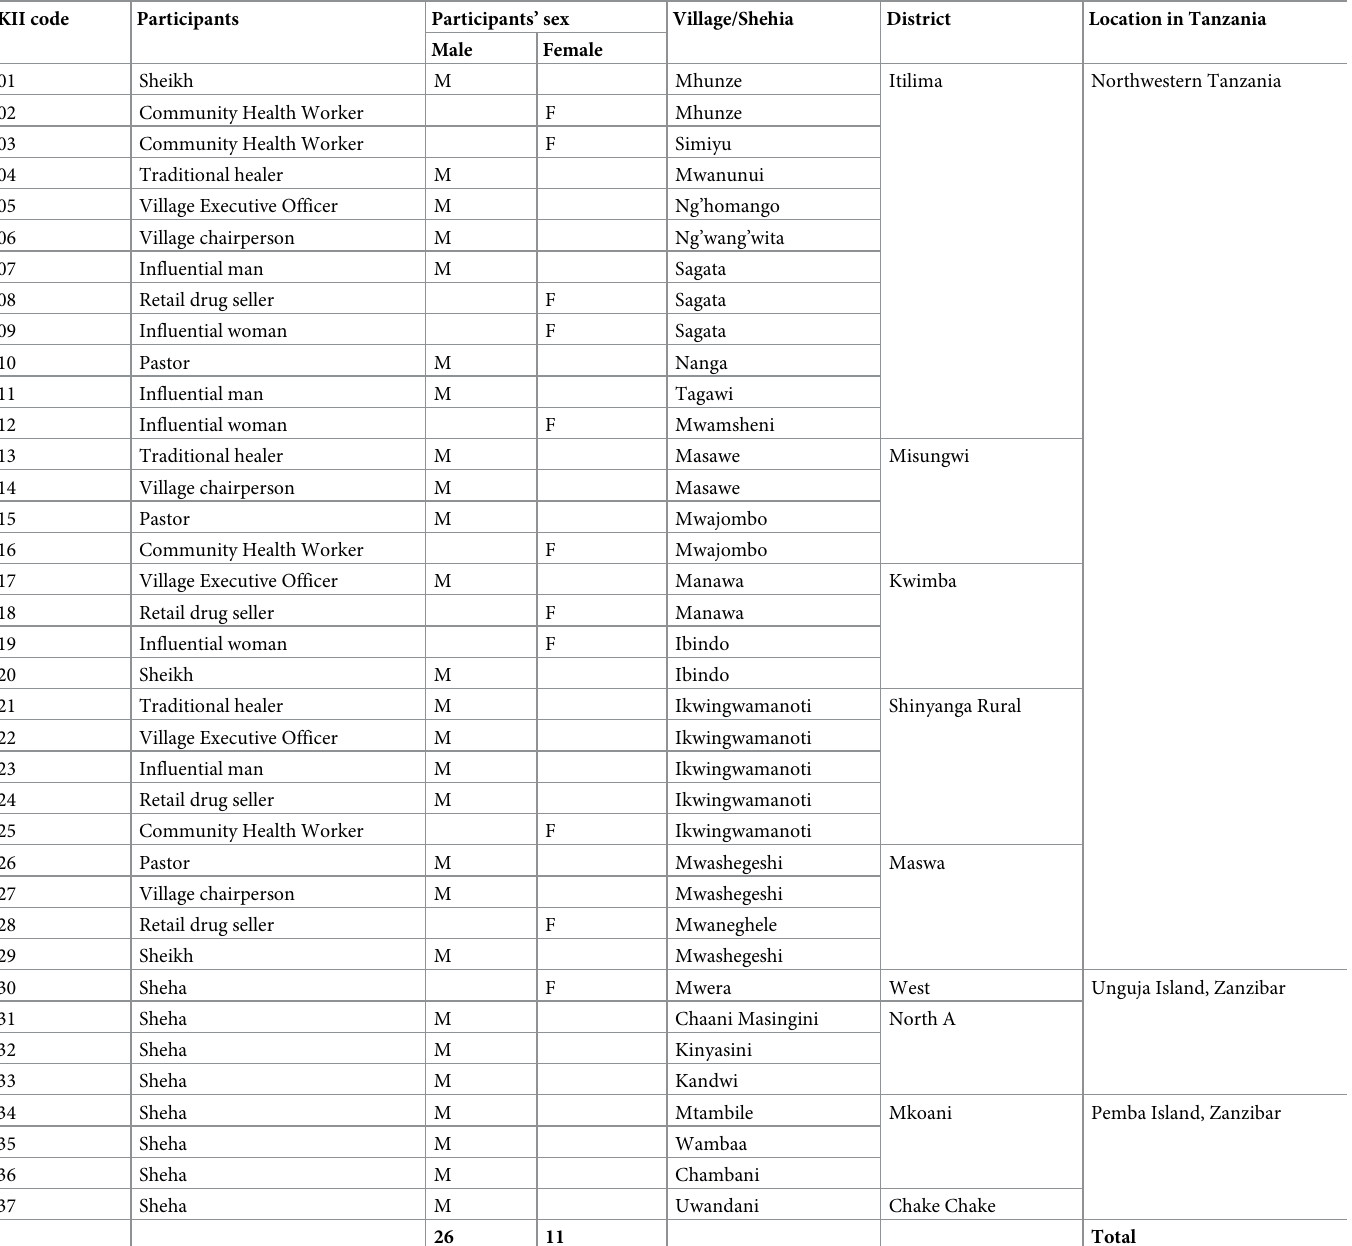
Table 2. Key informants, number of KIIs, and study sites KII